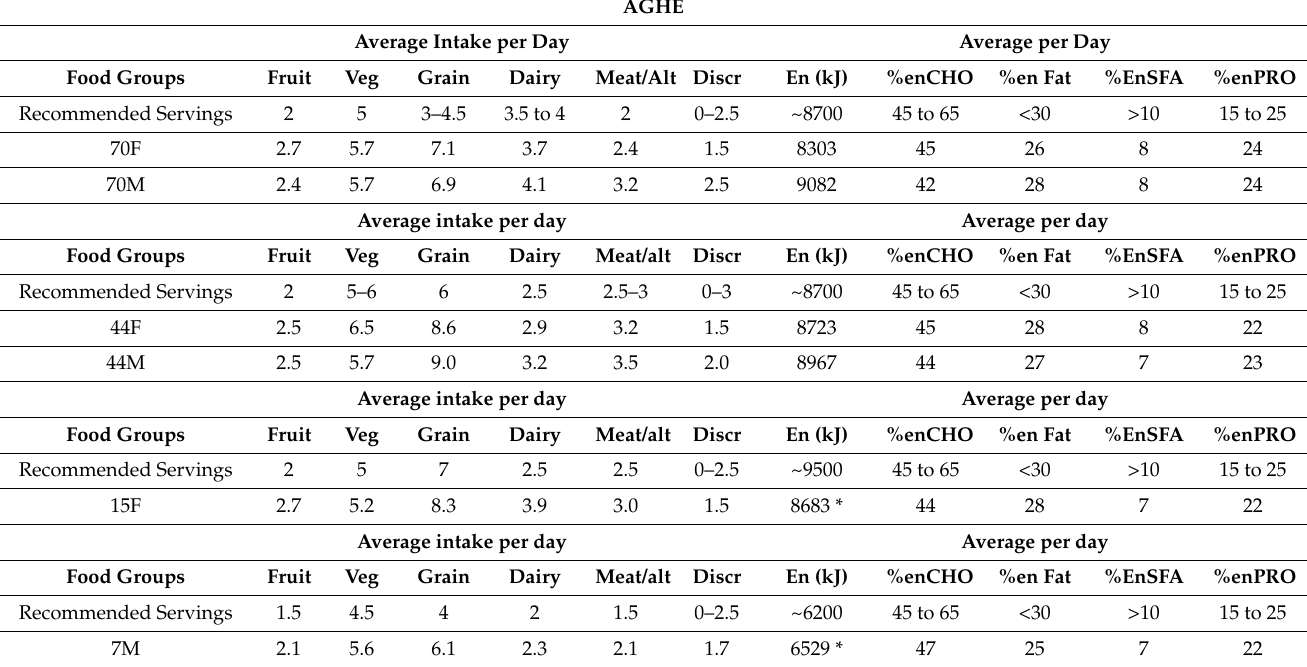
Table 4. Overview of average daily food group and discretionary intake and energy contributions for the AGHE food